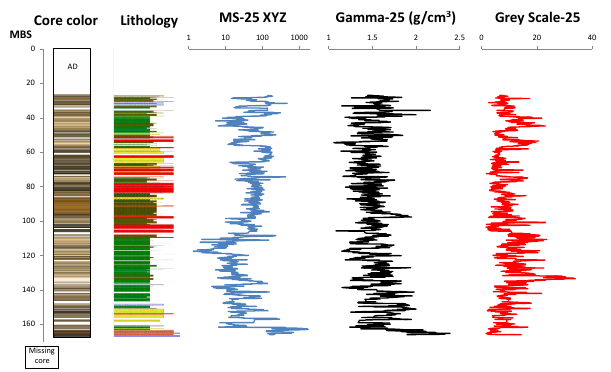
Figure 10. Summary stratigraphy of core ODP-OLO12-1A, from the Koora Plain/Olorgesailie drilling area, southern Kenyan Rift Valley, based on initial core description results. Columns from left to right: core color stratigraphy; lithologic log; see Fig. 5 for the key to lithologies used in all cores illustrated; composite of magnetic susceptibility (MS) log data (25-point running mean smooth) from LacCore Geotek © XYZ point sensor data; composite of induced gamma density log data (25-point running mean smooth, spurious values <1.0gmcm − 3 removed); and composite of spectrophoto- metric grey-scale log data (25-point running mean smooth). AD: auger drilled sediment samples were bagged and collected in 1m intervals. All other data collection, instrumentation, and parameters as in Fig.